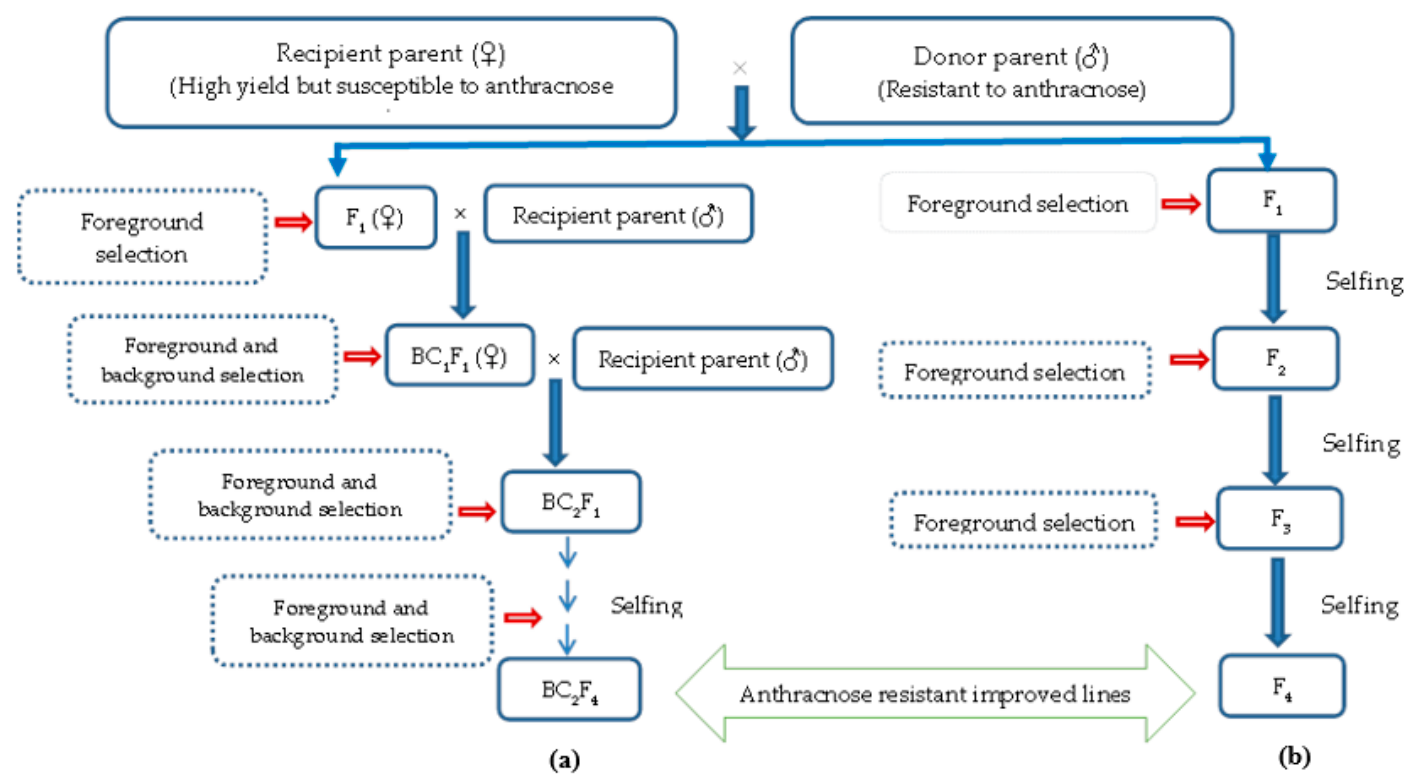
Figure 3. Diagram showing the development of anthracnose-resistant varieties through ( a ) marker-assisted backcrossing and ( b ) pedigree selection.